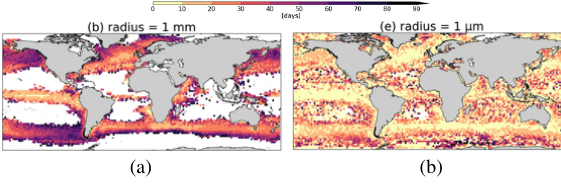
Figure 6. Initial scatter-plot depiction for sinking timescales of biofouled plastics by D.M.A.